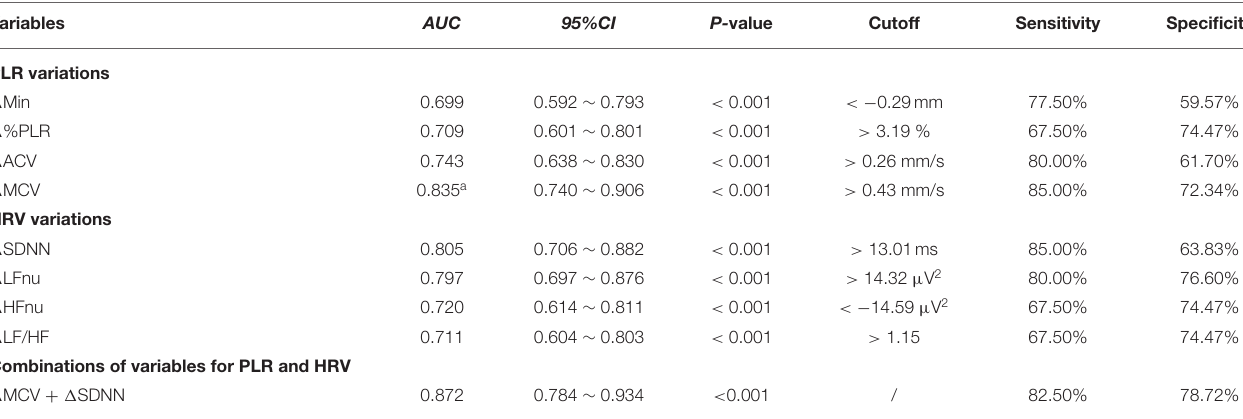
TABLE 2 | The characteristics of ROC